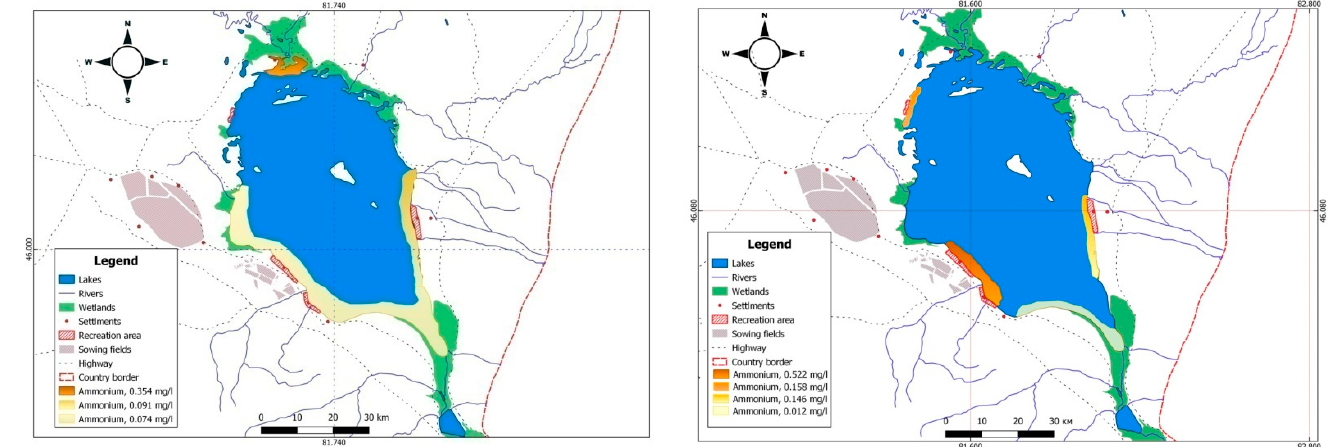
Figure 5. Distribution of ammonium ions in Lake Alakol in 2020 (left) and 2021 (right).